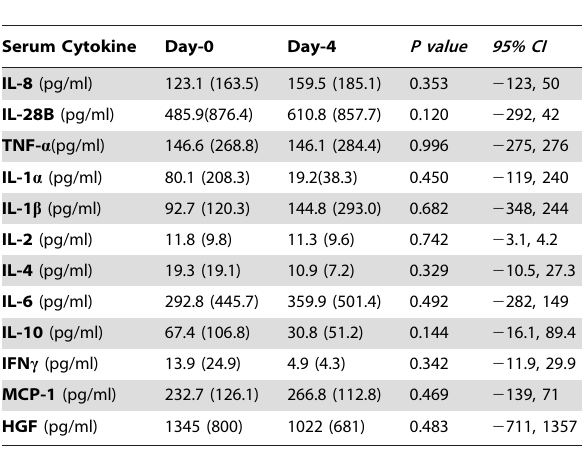
Table 10. Effects of Prednisone on serum